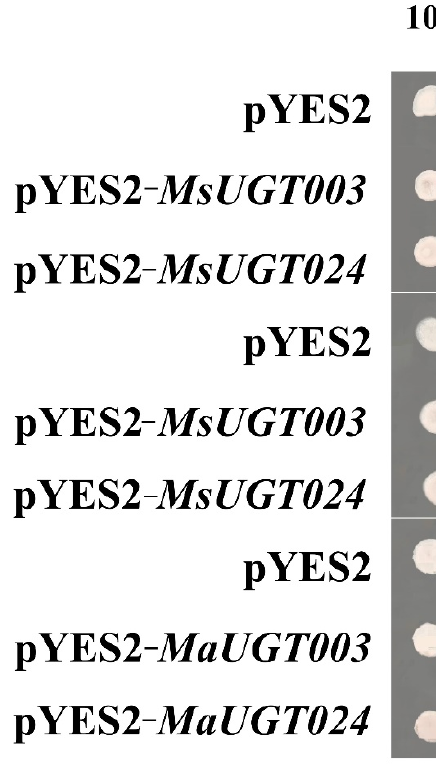
Figure 7. Drought stress tolerance and ABA treatment analysis of MsUGT003 and MsUGT024 genes in heterologous expression in yeast with the comparation of empty pYES2 (control) line. The serial dilutions (10 0 , 10 1 , 10 2 , 10 3 10 4 , 10 5 , 10 6 ) of yeast cultured under control, 30% PEG or 50 µ M ABA conditions were spotted onto solid medium containing SC−Ura.